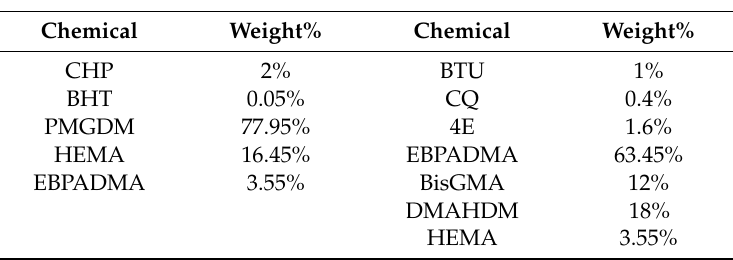
Table 5. Chemical composition of PEHB monomers with 5%